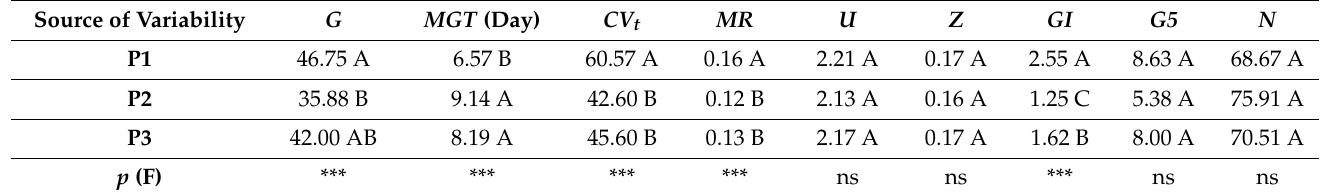
Table 3. Differences between three winter savory natural populations (P1, P2, and P3) in the first phase of the experiment for the germination parameters under drought stress.